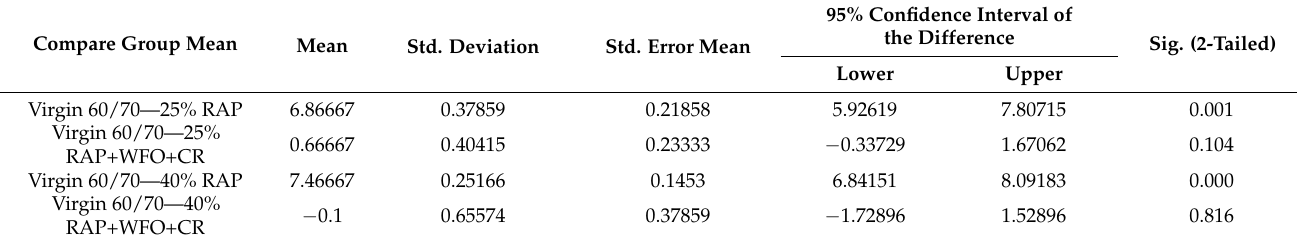
Table 7. Comparison of significant difference of group means for the bleeding